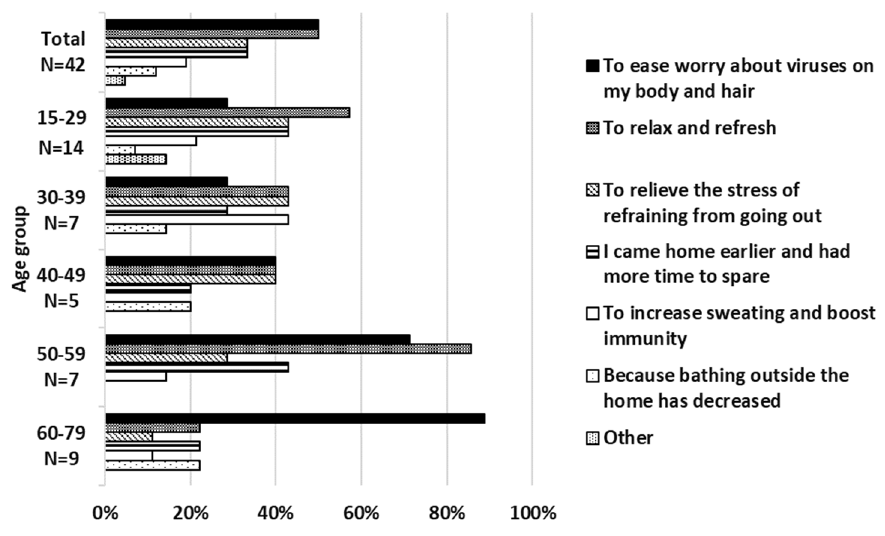
Figure 10. Reasons for increased frequency of bathing (multiple answers).